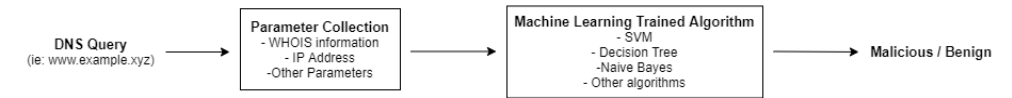
Figure 3. DNS query